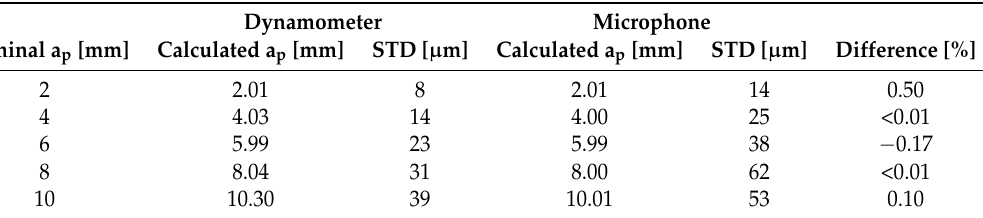
Table 6. Results with known nominal depth of cut.